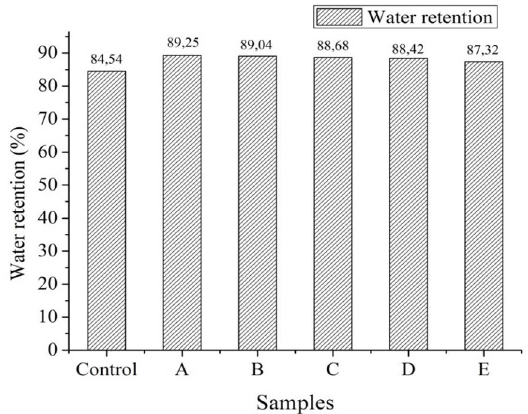
Figure 6. Results of the water retention test on the reference mortar and on the mortar with 5%, 10%, 15%, 20% and 30% of residue in partial replacement of the